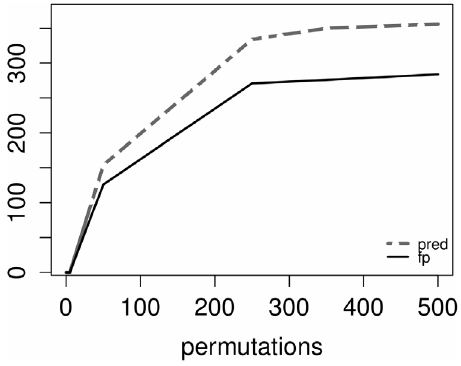
Figure 1. Number of predicted edges and false positives vs. number of permutations.